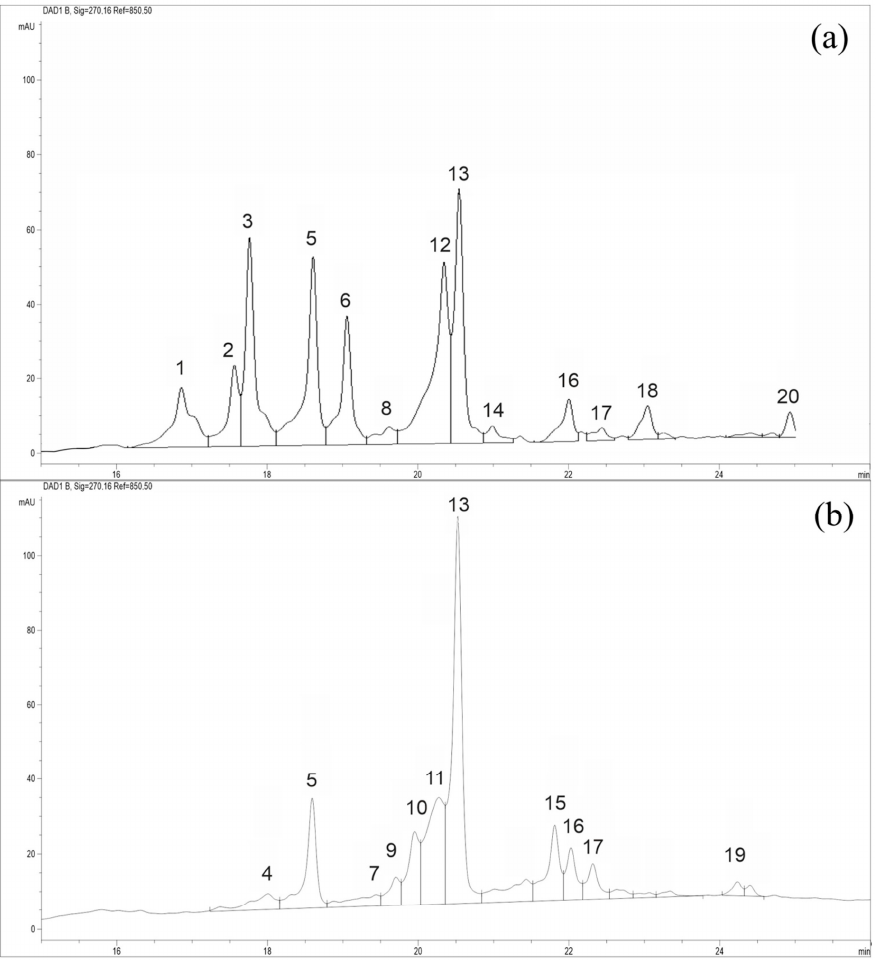
Figure 5. HPLC-MS chromatograms of 70% water–ethanol extracts Nitraria leaves: ( a ) N. sibirica , ( b ) N. iliensis . The abscissa is the retention time, t, min; ordinate—optical density, e.o.p., mAU;